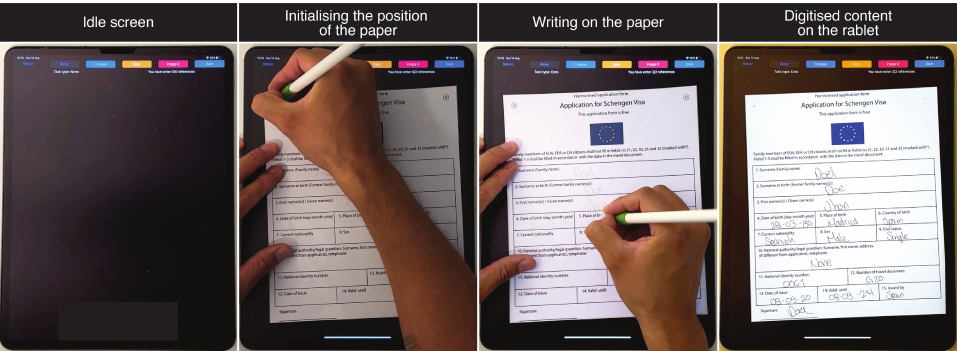
Figure 10. Form filling use-case.